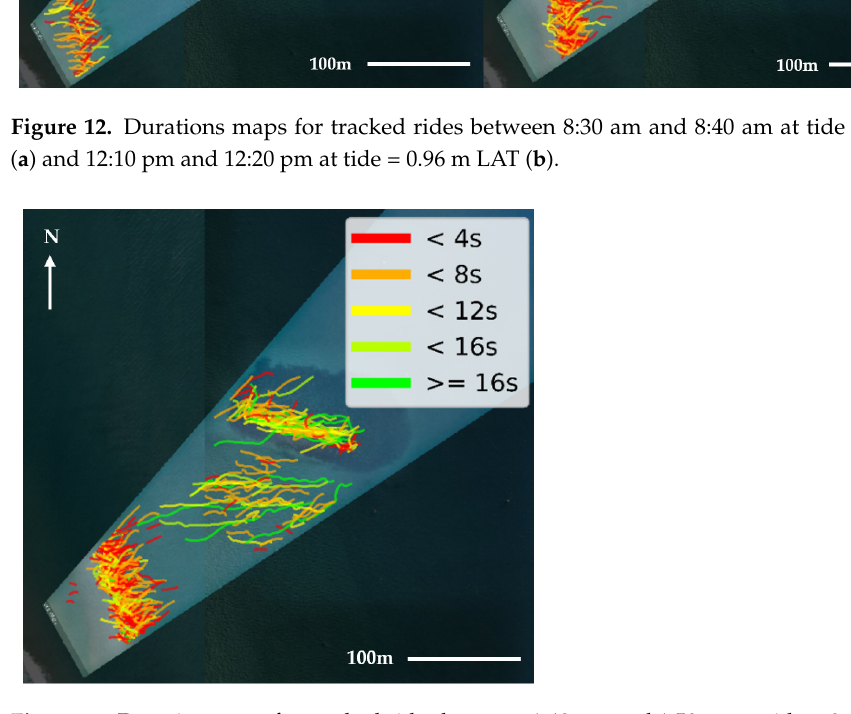
Figure 13. Durations map for tracked rides between 1:40 p.m. and 1:50 p.m. at tide = 0.44 m LAT.